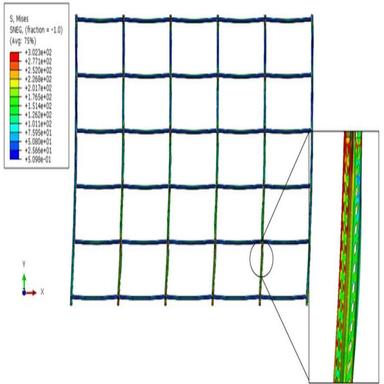
SR2: Von Mises stress-distribution at the middle surface at the peak load.